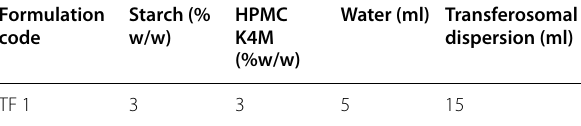
Table 3 Composition of transferosomal transdermal film Formulation Starch (% code